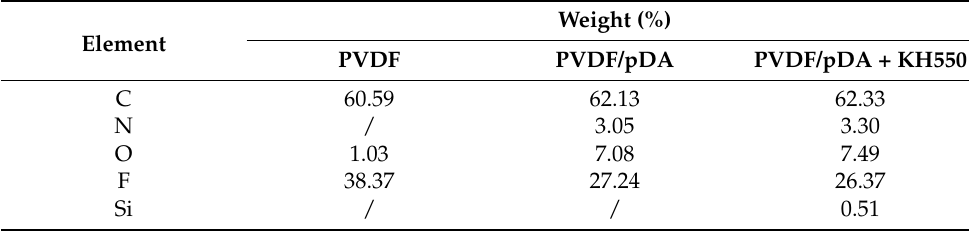
Figure 3. The EDS of elements of pristine and coated membrane surfaces. Table 2. The weight of elements on the surface of pristine and modified membranes.